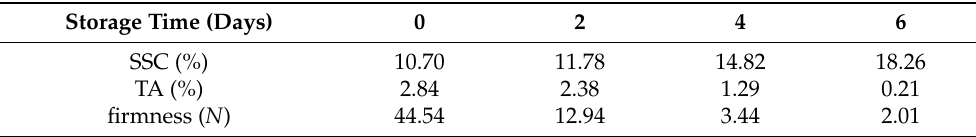
Figure 5. Color change of ripeness-indicator label with packaged mango fruit cv. Nam Dok Mai Si Thong at 27 °C; blue = unripe, light green = half-ripe and yellow = fully-ripe. Table 4. Effect of changes in mango fruit cv. Nam Dok Mai Si Thong firmness, SSC, and TA during storage at 27 °C.